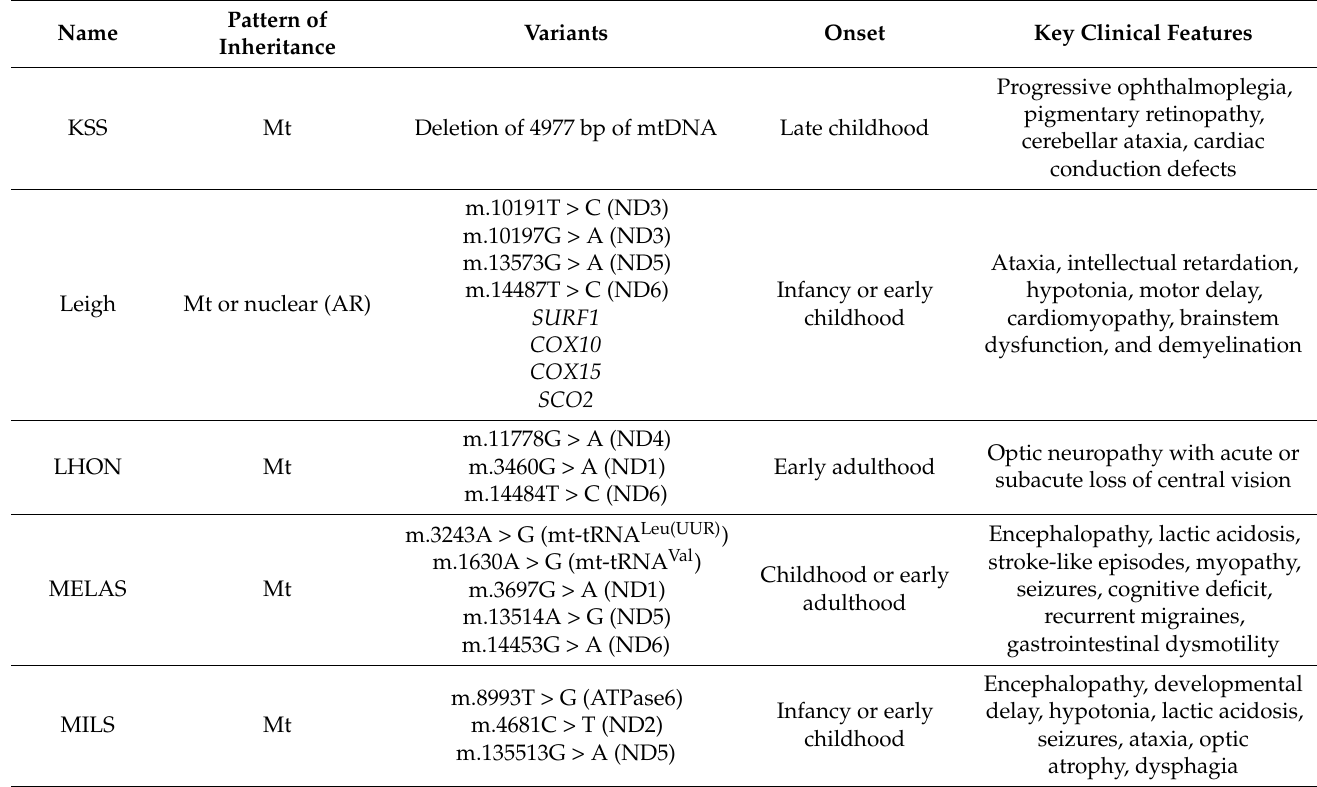
Table 1. The most frequent primary mitochondrial diseases with maternal or autosomal